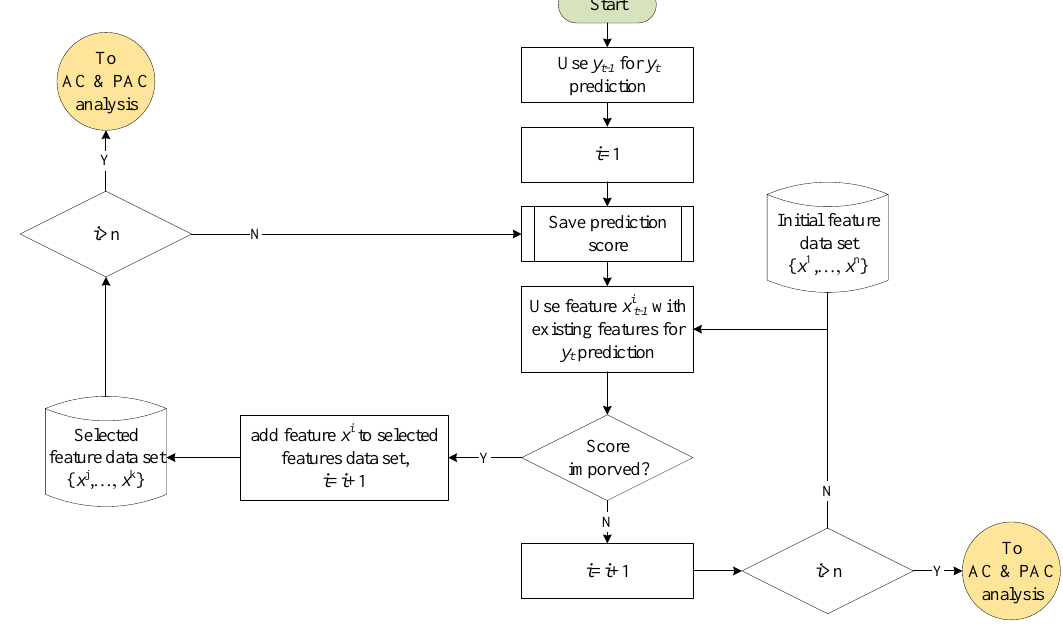
Figure 7. Forward feature selection